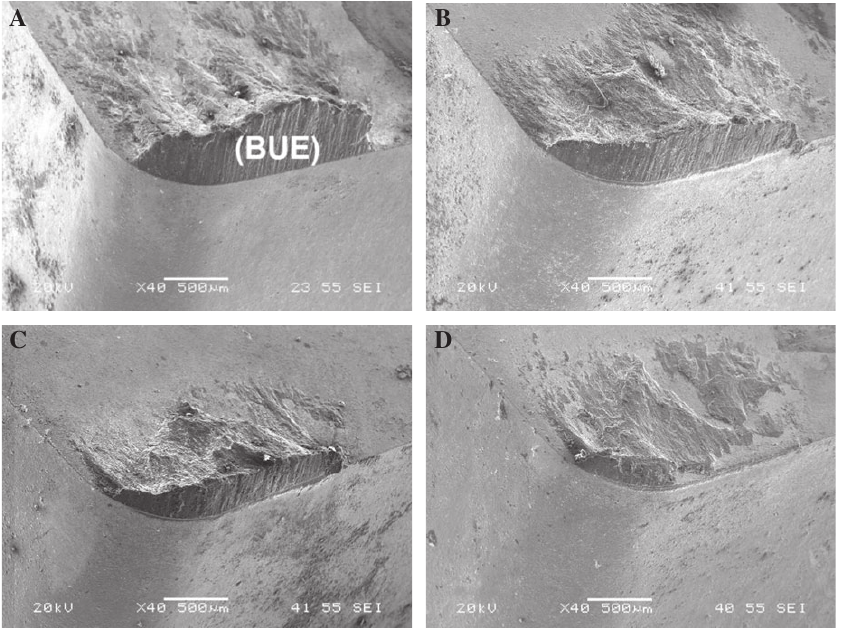
Figure 9 SEM photos of cutting edges in the 10 % MgO reinforced MMC specimen with C tool at 0.075 mm/rpm feed rate and 150 (A), 200 (B), 250 (C) and 300 (D) m/min cutting speeds. The SEM images (C) and (D) indicate that in higher cutting speeds, an amount of BUE moved away from the cutting tool edge and BUE formation was lower. This reduced the effect of machining in the cutting area and led to